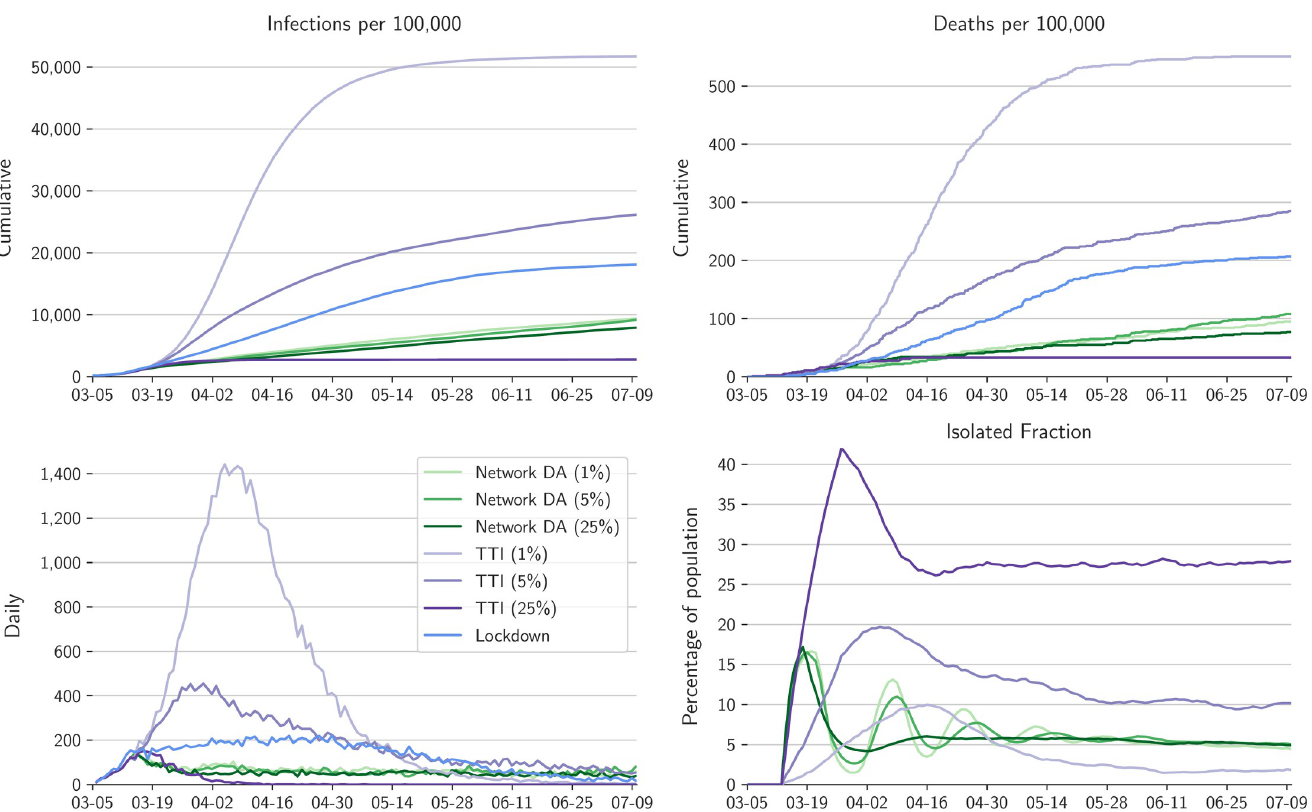
Fig 4. Comparison of different contact intervention scenarios for full user base with ~ N = N ¼ 100% . Shown are the lockdown scenario (blue) from Fig 2, the results of network DA and isolation of positive individuals for test rates f = 1%, 5%, and 25% (greens), and the results of TTI with the same test rates as for network DA